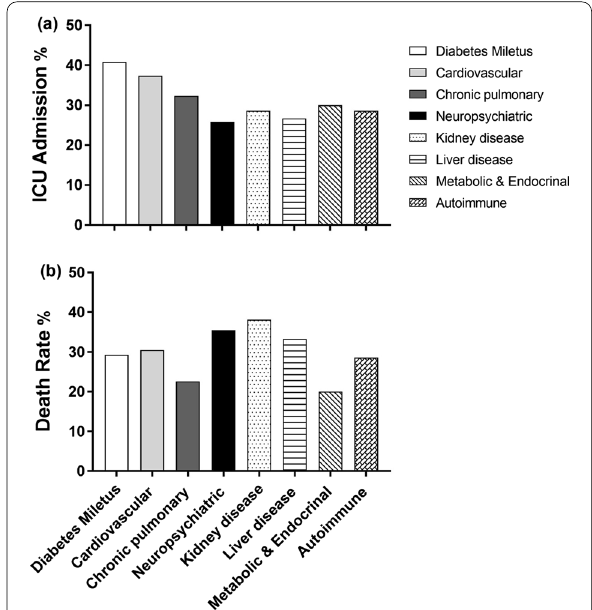
Table 4 Clinical outcomes of COVID‑19 patients included in the study ( n